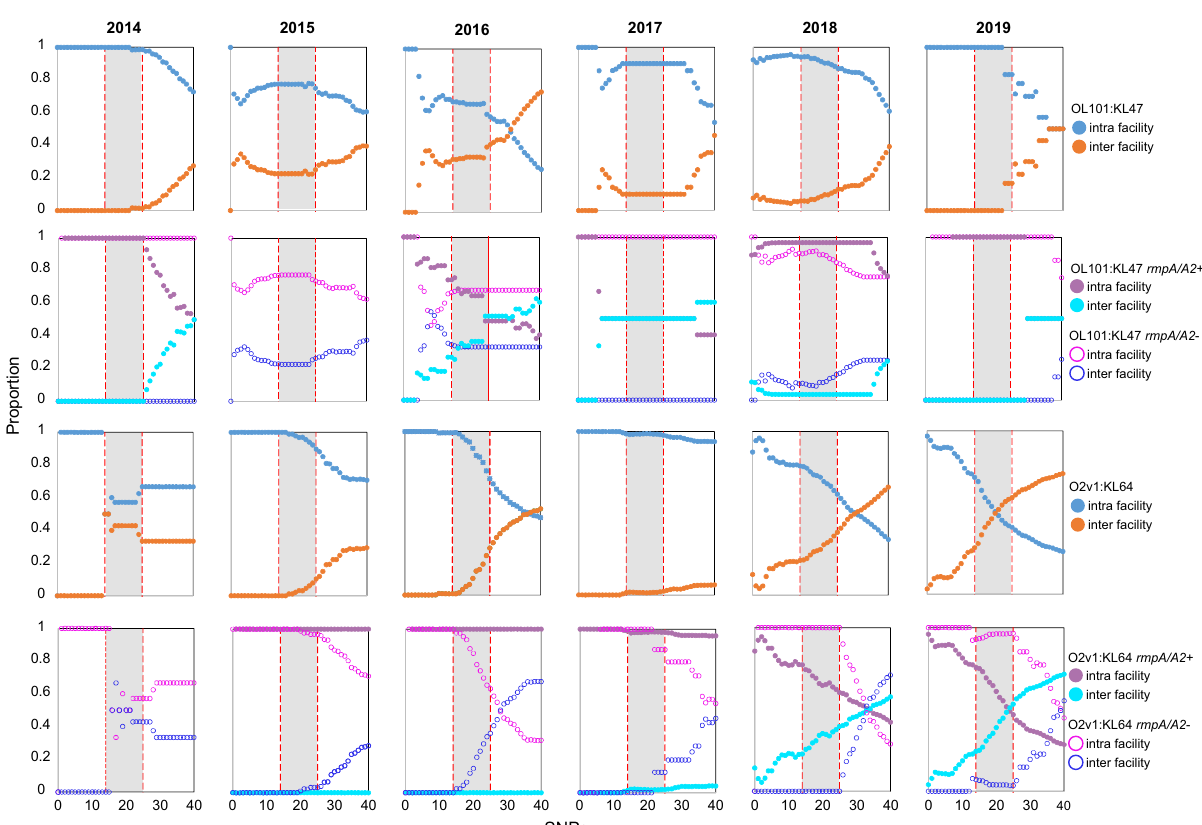
Fig. 7 | Temporal transmission dynamics of OL101:KL47 and O2v1:KL64 (2014 – 2019). Recent intra- and inter-facility transmission pairs using pairwise single-nucleotide polymorphism (SNP) distances were identi fi ed by year. Circles indicate the proportion of pairs ( y- axis) calculated by using various pairwise SNP